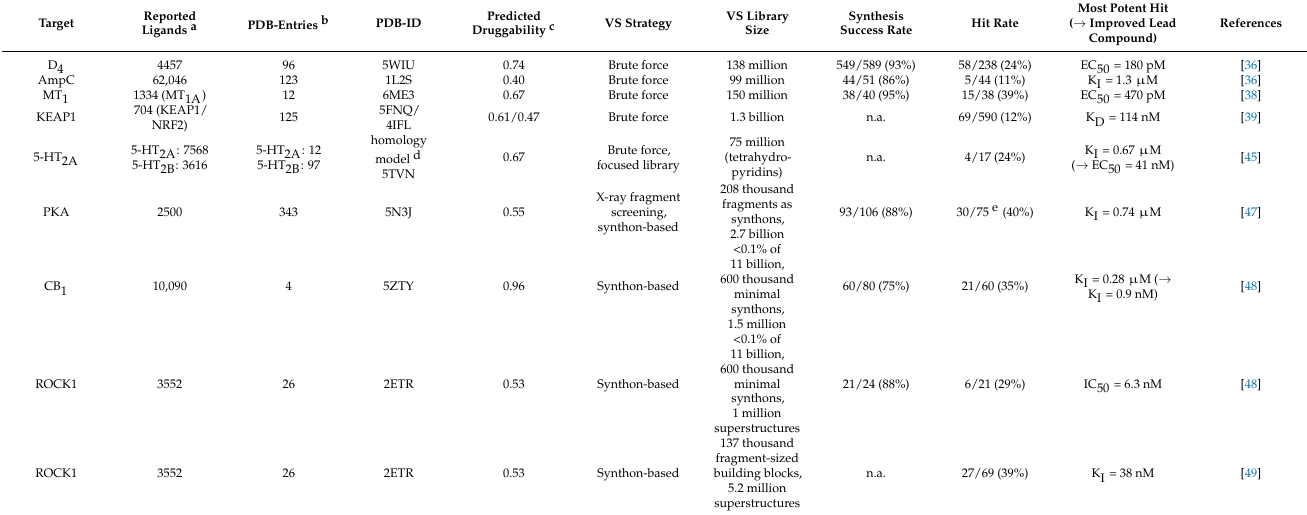
Table 1. Recent examples of (ultra-)large library structure-based virtual screenings and results from this